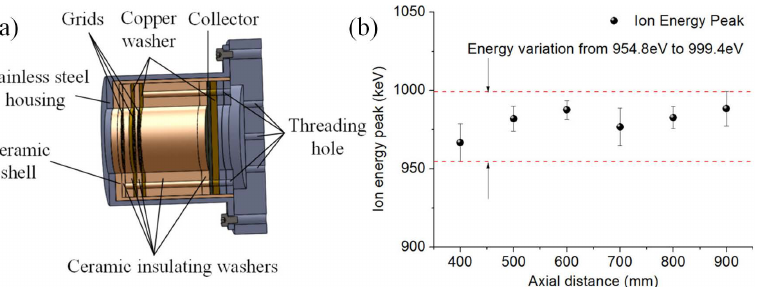
Figure 14. ( a ) Schematic of the retarding potential analyzer (RPA) and ( b ) the corresponding measured ion energy of the LIPS-200 ion thruster